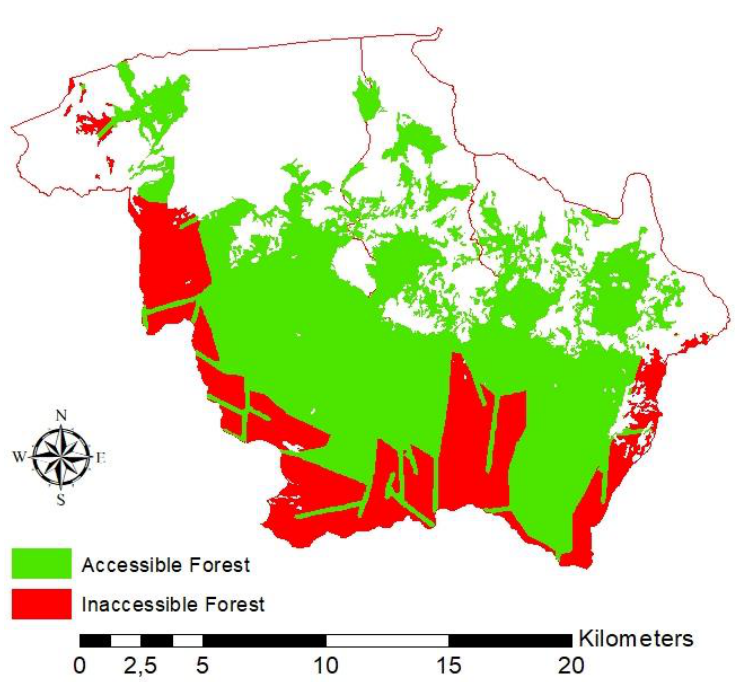
Figure 7. The accessible forest by adding the new firefighting